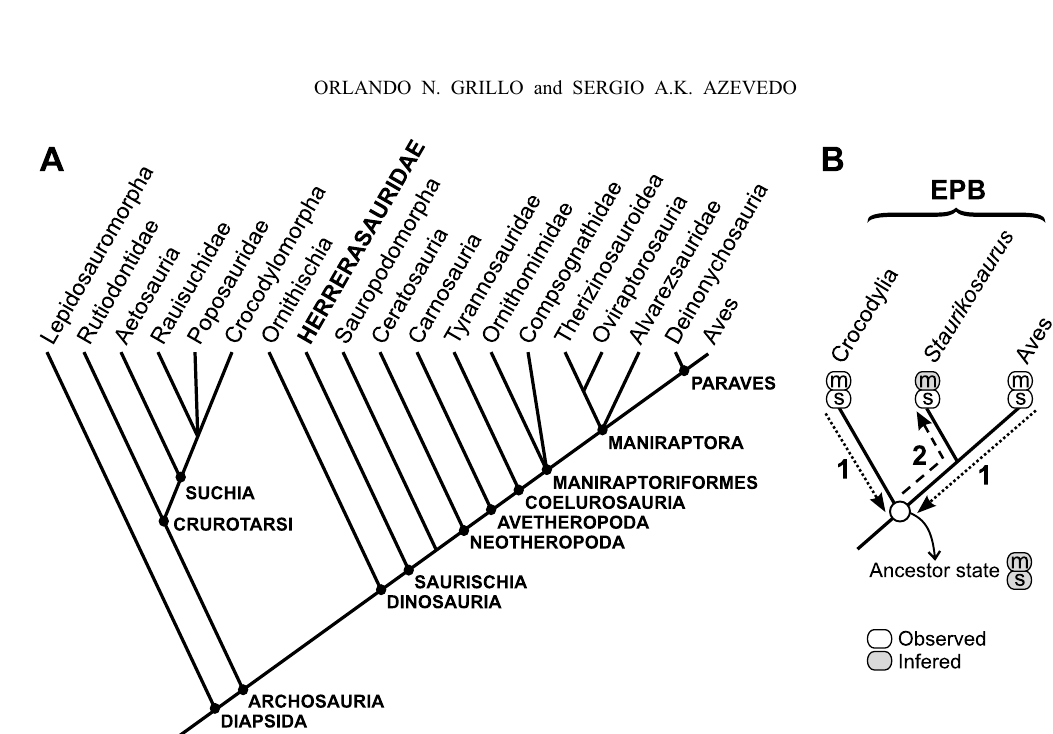
Fig. 1–Phylogeneticframeworkadoptedinthisstudy,depictingthepositionofHerrerasauridae(A)andtheapplicationoftheEPBto Staurikosaurus muscle reconstruction (B): (1) Inference of the status of the osteological structure (s) and muscle (m) in the closest common ancestor of the extant taxa from the observation of the extant taxa; (2) if the inference indicates that the muscle was present in the ancestor, the most parsimonious condition indicates that it was also present in the extinct taxon ( Staurikosaurus ). Inferences are shown in gray circles (adapted from Witmer